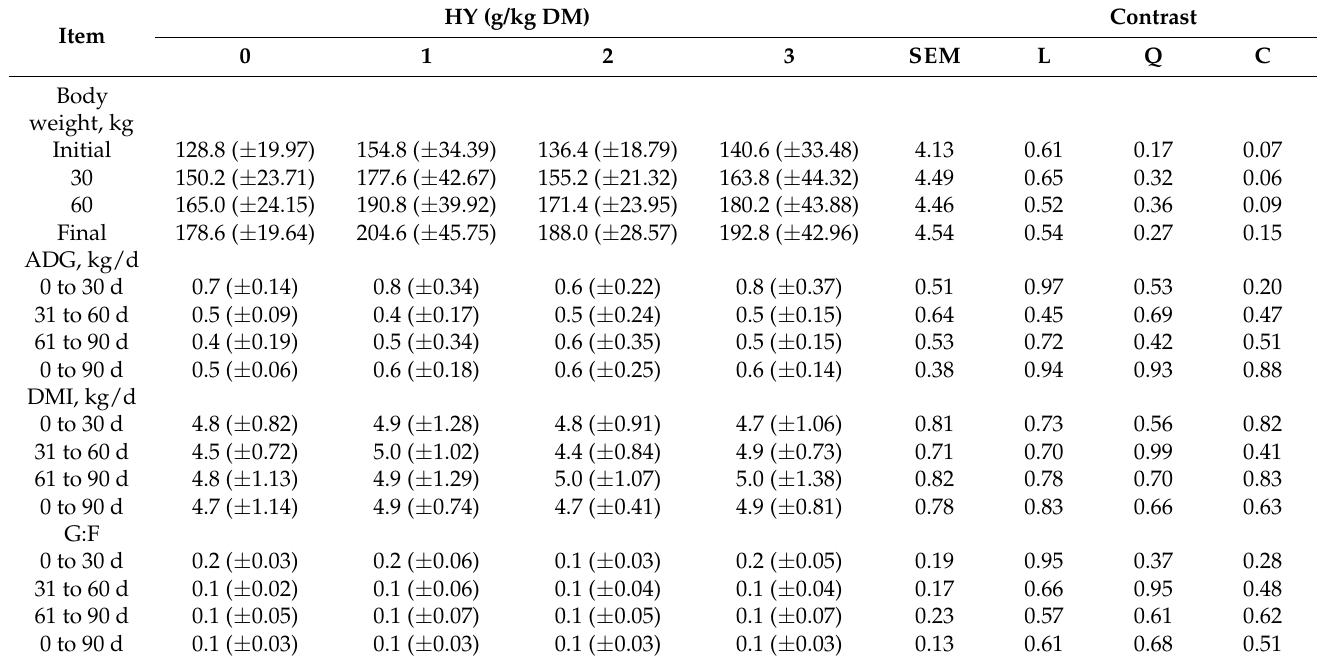
Table 2. Effect of HY supplementation on growth performance in growing beef